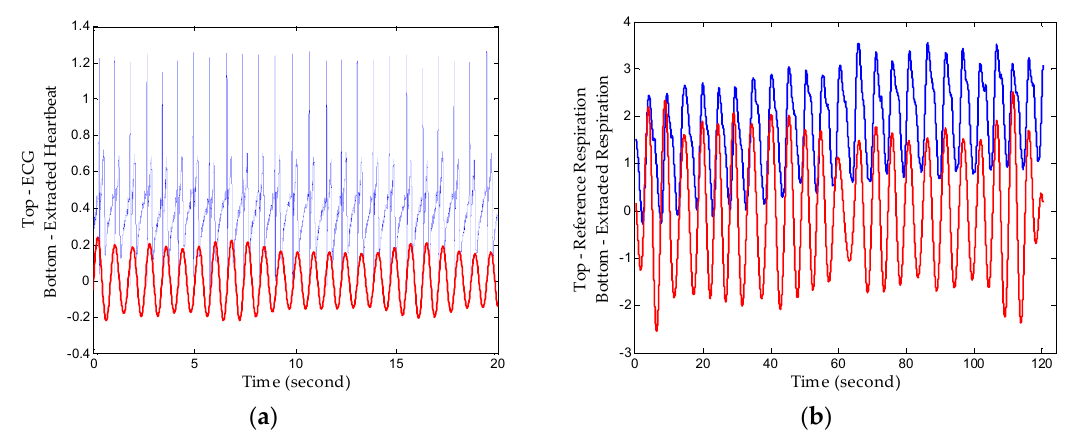
Figure 13. Extracted signals compared with reference signals. ( a ) Extracted heartbeat signal and ECG reference signal; ( b ) extracted respiration signal and respiration reference signal.